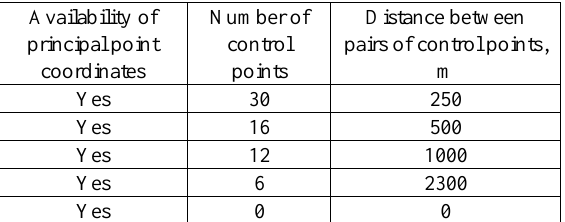
Table 1. The initial data sets used for generation of photogrammetric